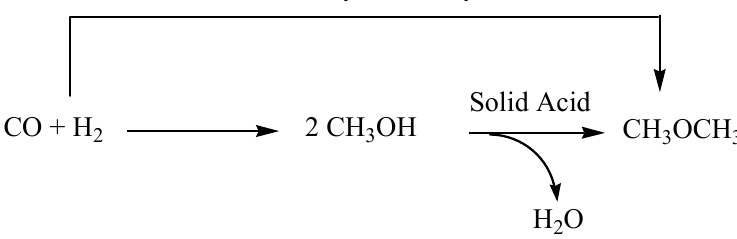
Bifunctional or hybrid